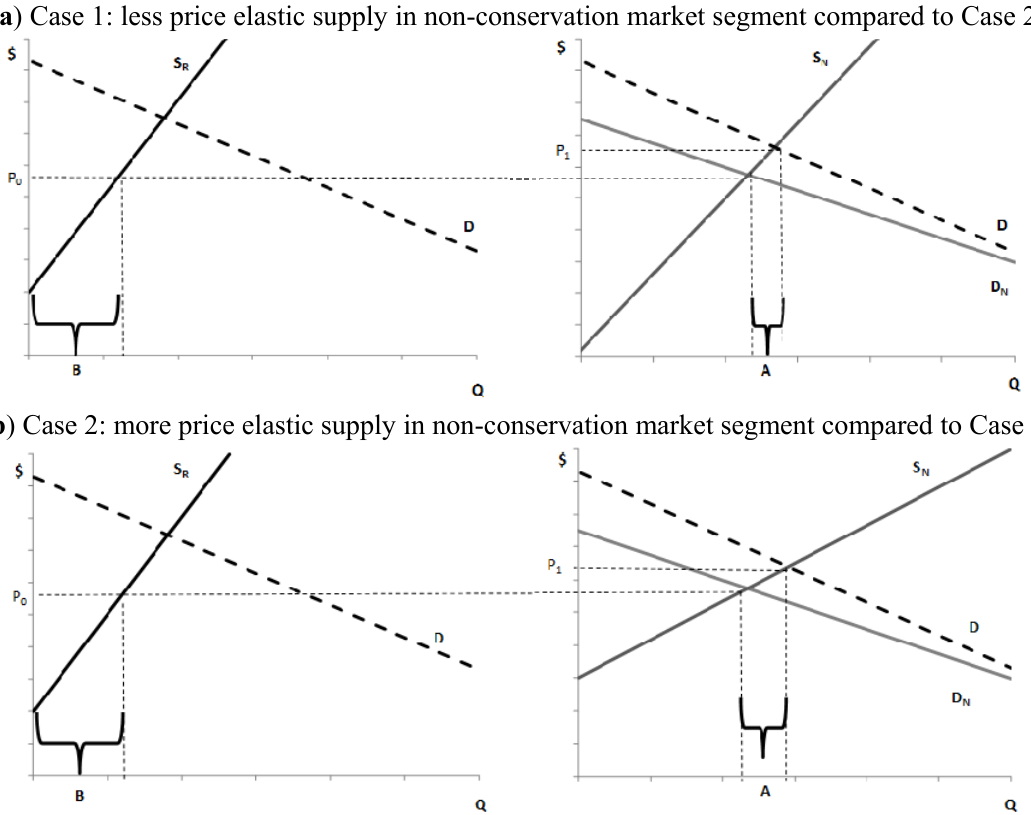
Figure 1. Market effects leakage from forest conservation: ( a , b ) a two-country case assuming perfect substitutability, adapted from Murray et al.